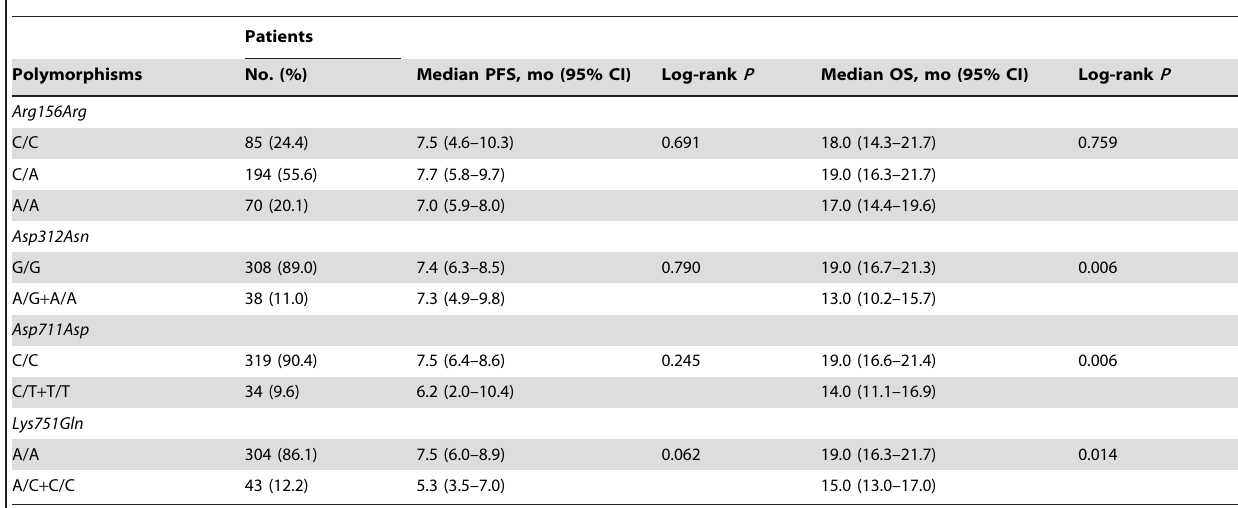
Table 3. PFS and OS according to XPD polymorphisms.